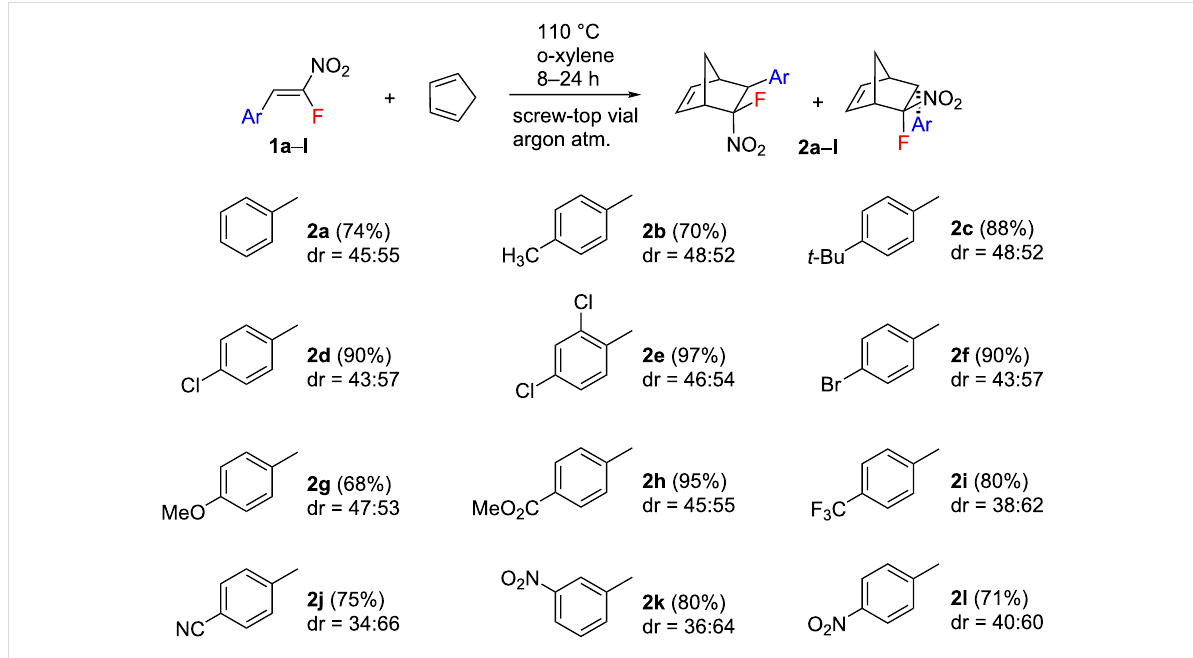
Scheme 1: Scope of the nitrostyrenes 1 in the Diels–Alder reaction with CPD (dr = exo : endo